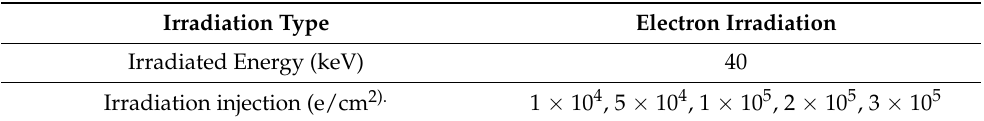
Table 2. Electron irradiation experimental parameters.